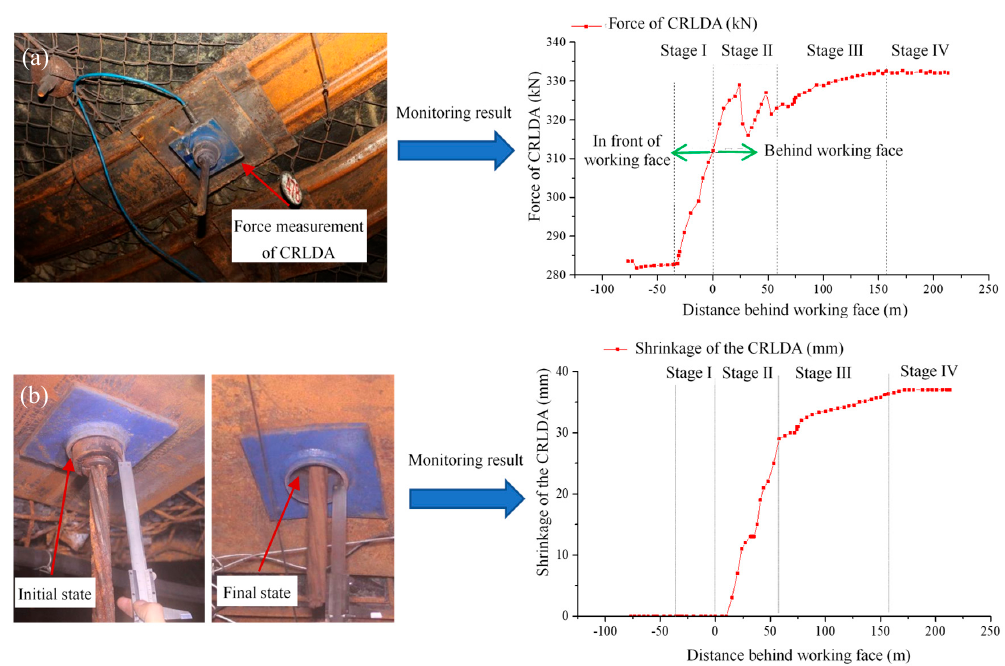
Figure 15. Force and shrinkage monitoring curves of CRLDA. ( a ) force monitoring and curve of CRLDA; ( b ) shrinkage monitoring and curve of CRLDA.